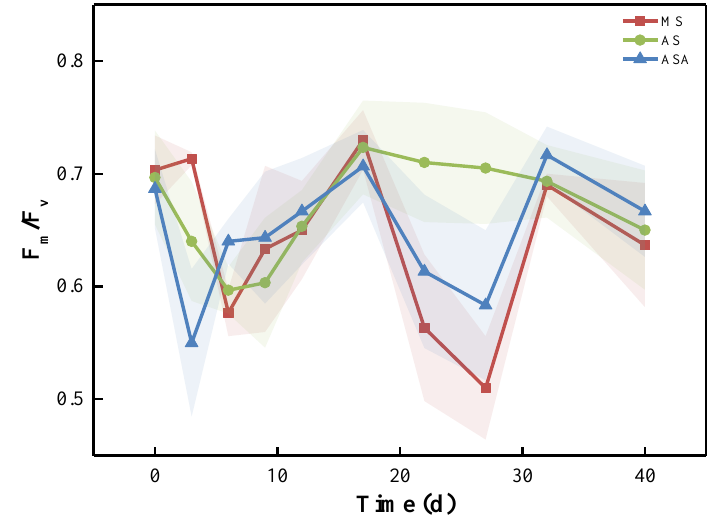
Figure 4. Change in V. natans F v / F m ratios in MS, AS and ASA groups. Notes: The shaded area indicates error range.